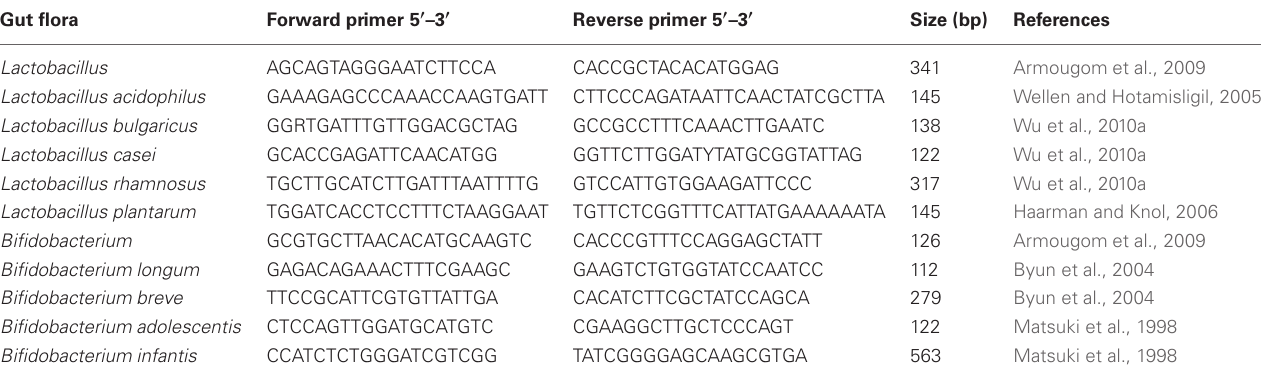
Table 1 | PCR primers for detection of Bifidobacterium and Lactobacillus. Gut flora Forward primer 5 (cid:2) –3 (cid:2)